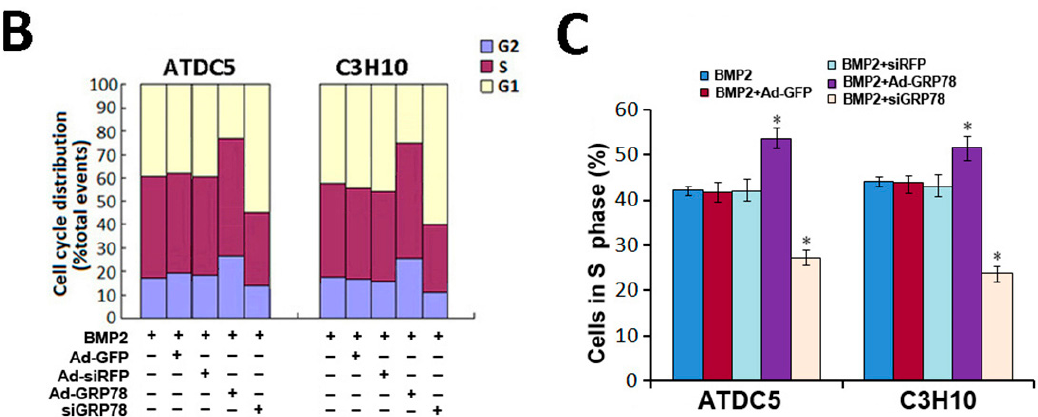
Figure 4. Cellular proliferation analysis by FCM. ( A ) Flow cytometry images with propidium iodide staining and analysis on cell cycle distribution. Micromass culture of ATDC5 cells and C3H10T1/2 were treated with BMP2 (300 ng/mL) / BMP2 + Ad-GFP/BMP2 + Ad-siRFP / BMP2 + Ad-GRP78 / BMP2 + Ad-siGRP78. Flow cytometry analysis showed that the percentage of the BMP2 + Ad-GRP78 ATDC5 cells in S phase were increased significantly compared to those in BMP2 controls, whereas the percentage of the BMP2 + Ad-siGRP78 ATDC5 cells in S phase were dramatically decreased compared with BMP2 control. The result of C3H10T1/2 is the same. Experiments were repeated three times, and samples were analyzed by Student’s t -test and statistical significance with p < 0.05. Representative images were shown; ( B ) Flow cytometry assay on the percentages of the ATDC5 and C3H10T1/2 cells in G2/M phase after treatment with BMP2 (300 ng/mL)/BMP2 + Ad-GFP / BMP2 + Ad-siRFP / BMP2 + Ad-GRP78 / BMP2 + Ad-siGRP78; ( C ) Flow cytometry analysis showed that the percentages of the ATDC5 and C3H10T1/2 Ad-GRP78 cells in S phase were increased significantly, whereas the percentages of the ATDC5 and C3H10T1/2 Ad-siGRP78 cells in S phase were decreased compared with those in their controls. * p < 0.05 compared with